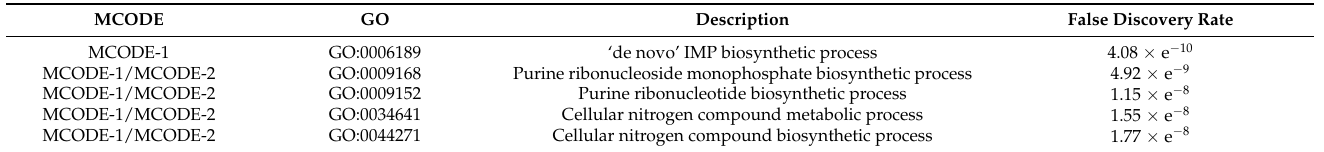
Table 2. Enrichment analysis of the top 2 MCODE genes function.